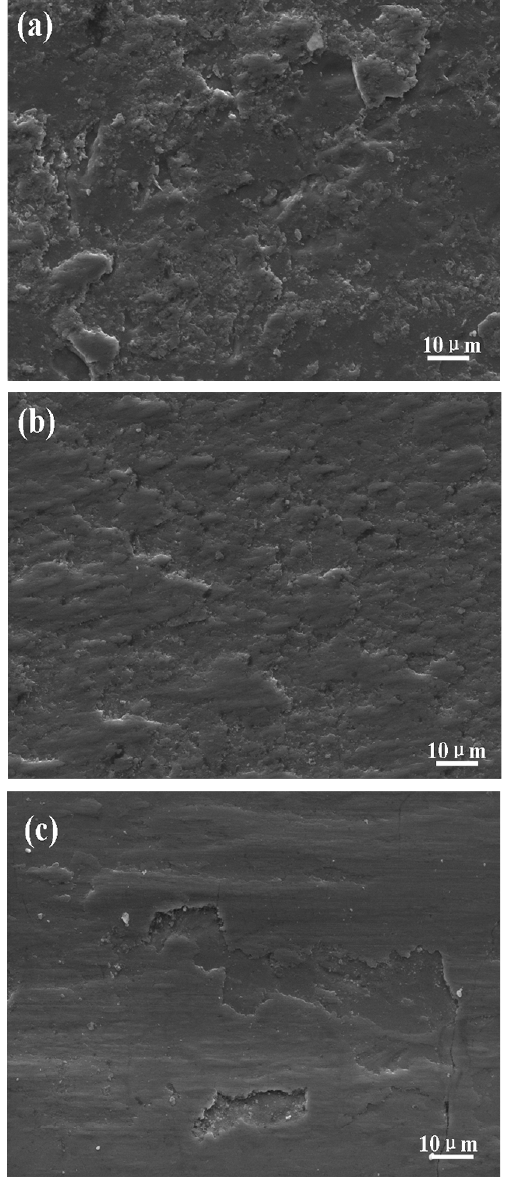
Fig. 8 Friction surface of Ti 2 AlC bulk after sliding friction of (a) 10 m/s and 80 N, (b) 20 m/s and 80 N, (c) 30 m/s and 80 N.